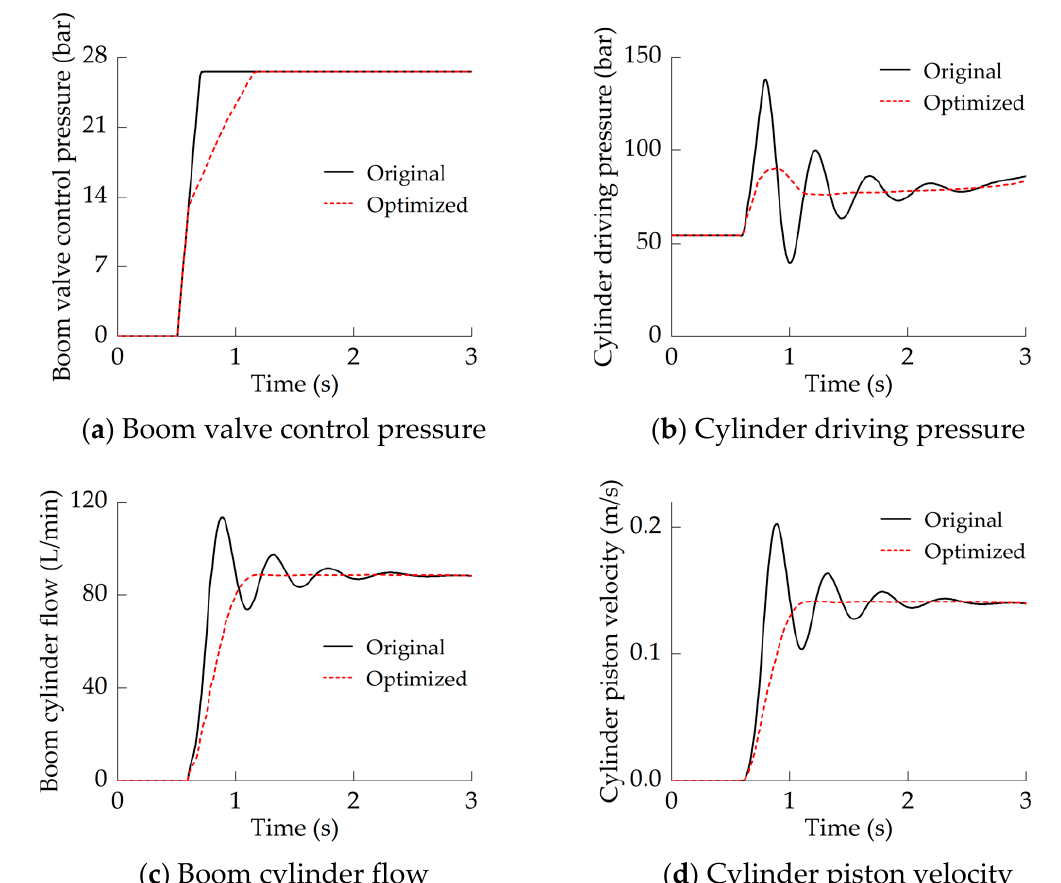
Figure 14. Boom cylinder acceleration characteristics.